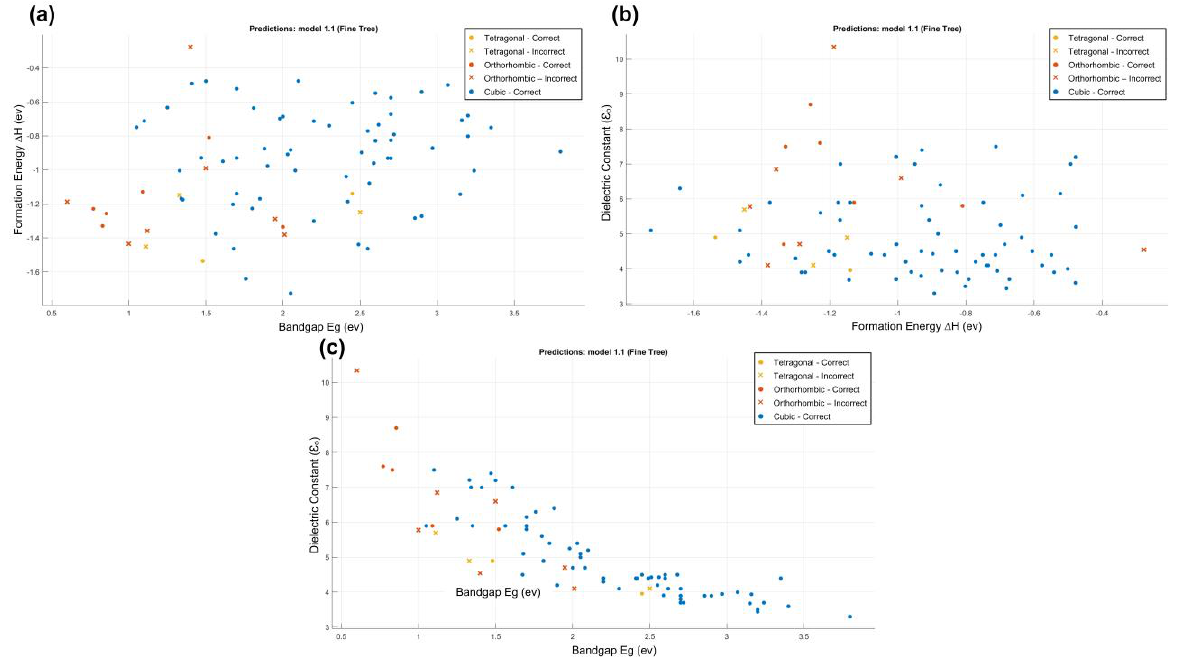
Figure 6. The classification error representation of the tree classifier, where x points represent the incorrect classification of data. ( a ) Formation Energy; ( b ) Band gap; ( c ) Dielectric constant.